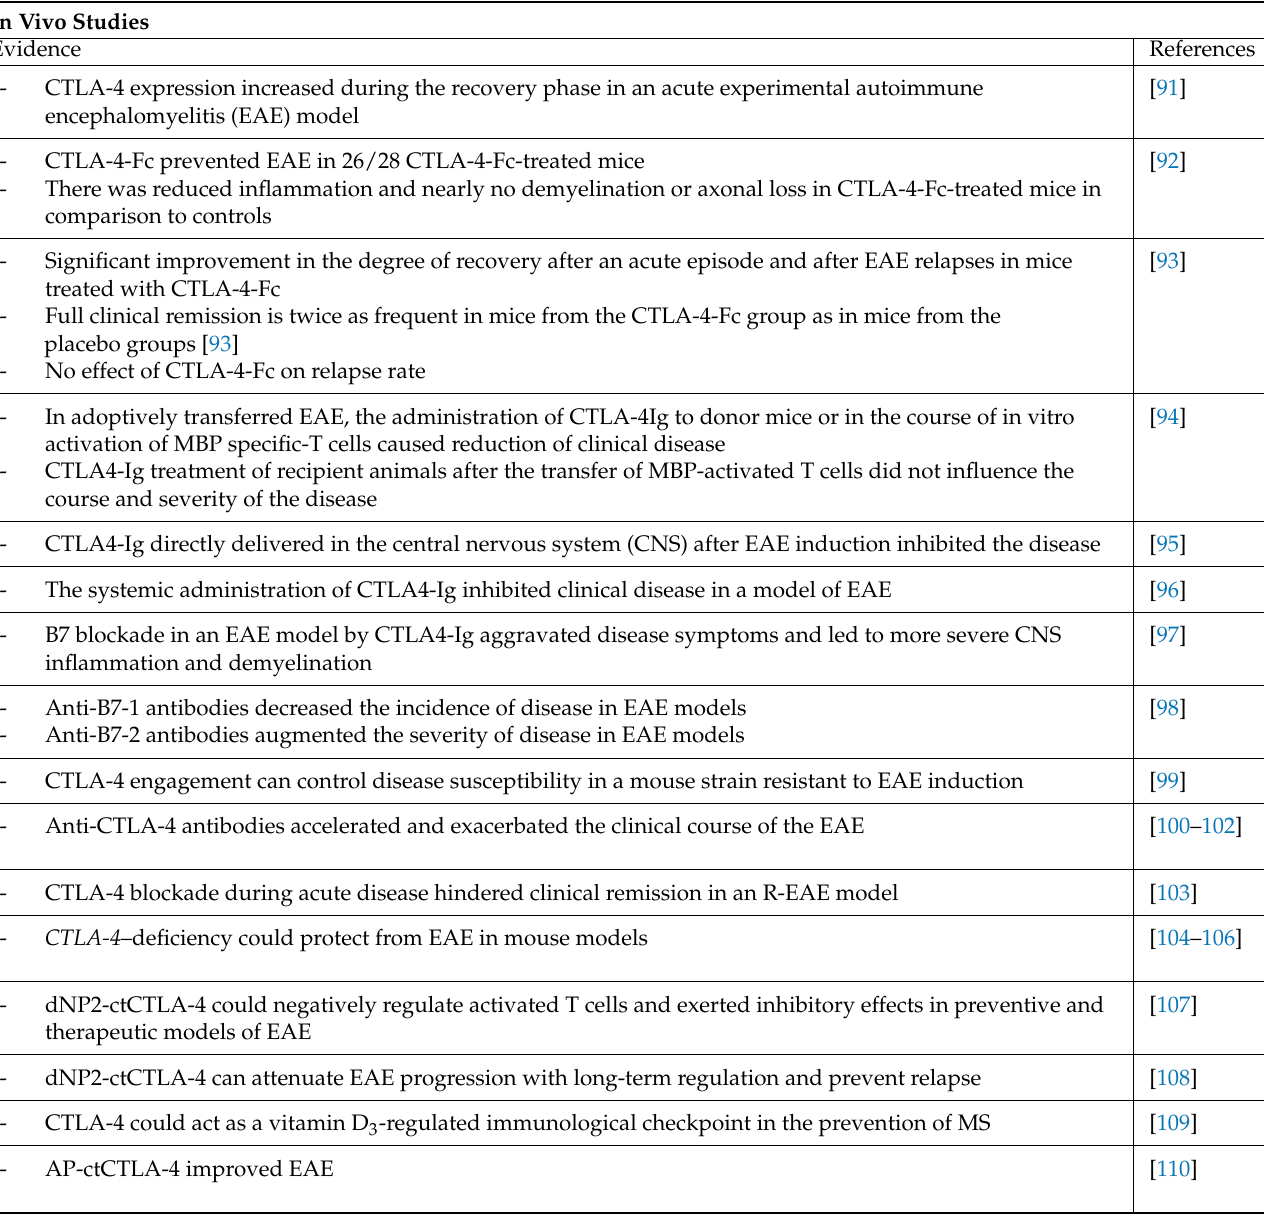
Table 2. Schematic overview of the most important evidence from the preclinical in vivo studies investigating the role of CTLA-4 in